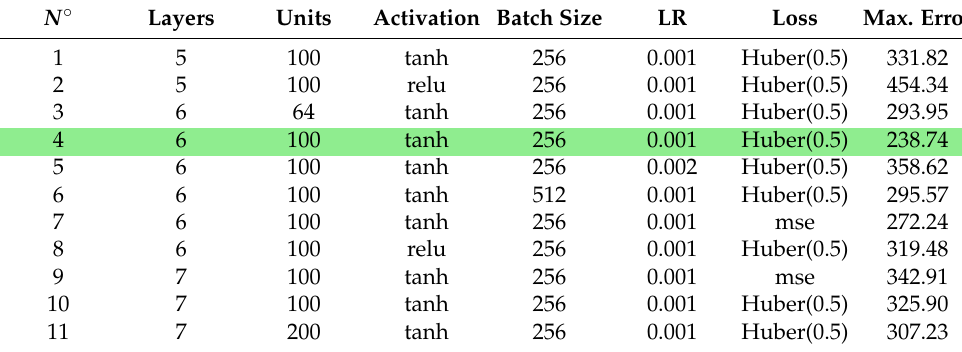
Table 7. Results of differents models for arrival times with ReduceLROnPlateau callback. Green row is the individual model